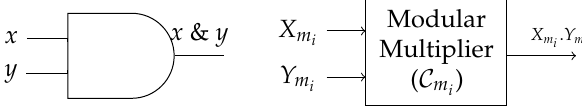
Figure 1. RNS circuit